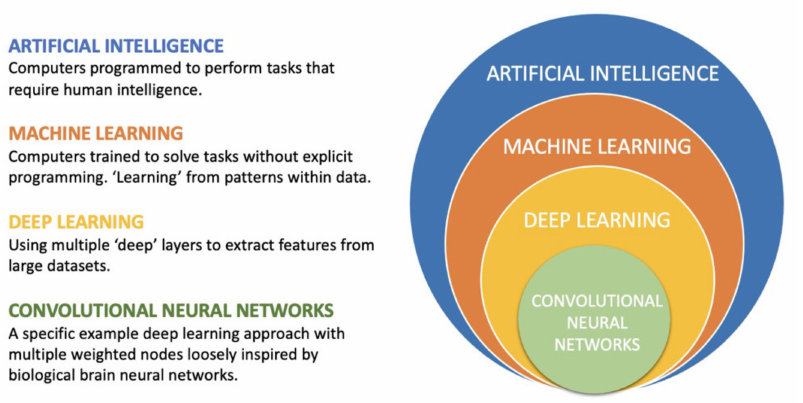
Figure 4. Layers of artificial intelligence approaches applied to medical